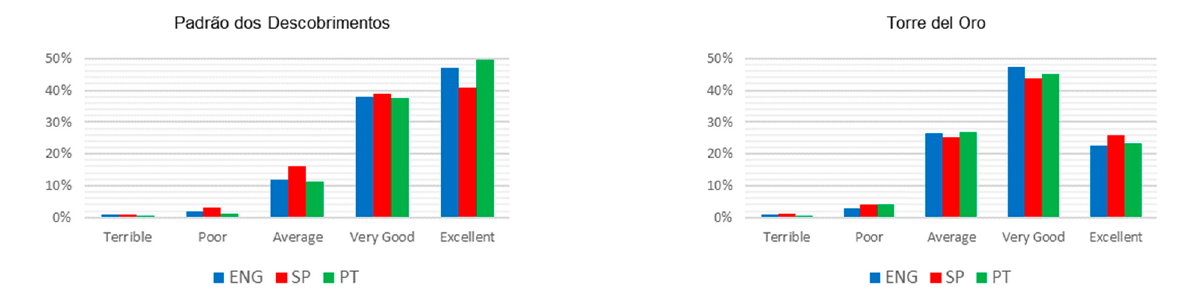
Figure 7. Rating values given on TripAdvisor for each case of the study.